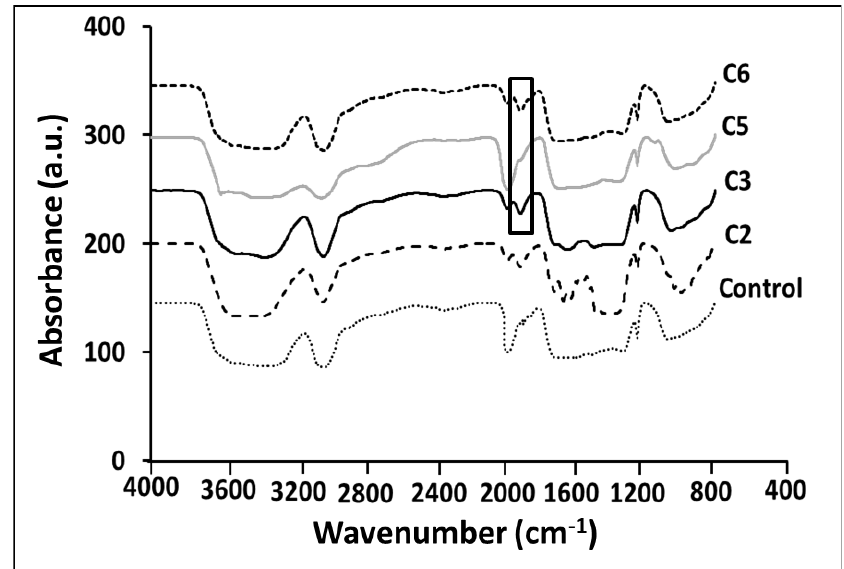
Figure 2. FTIR spectra of the control and group A samples.